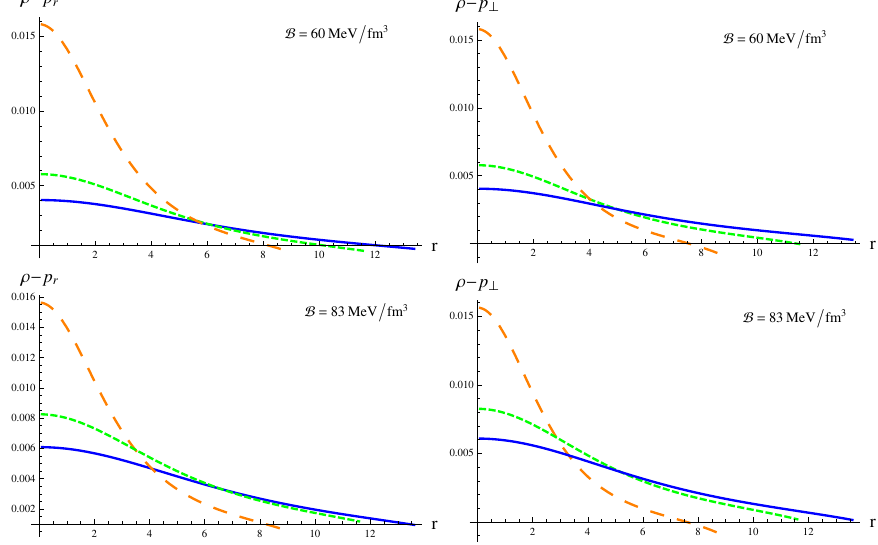
Figure 6. DEC (with ρ , p r , p ⊥ in km − 2 ) against the radial coordinate m Ψ =